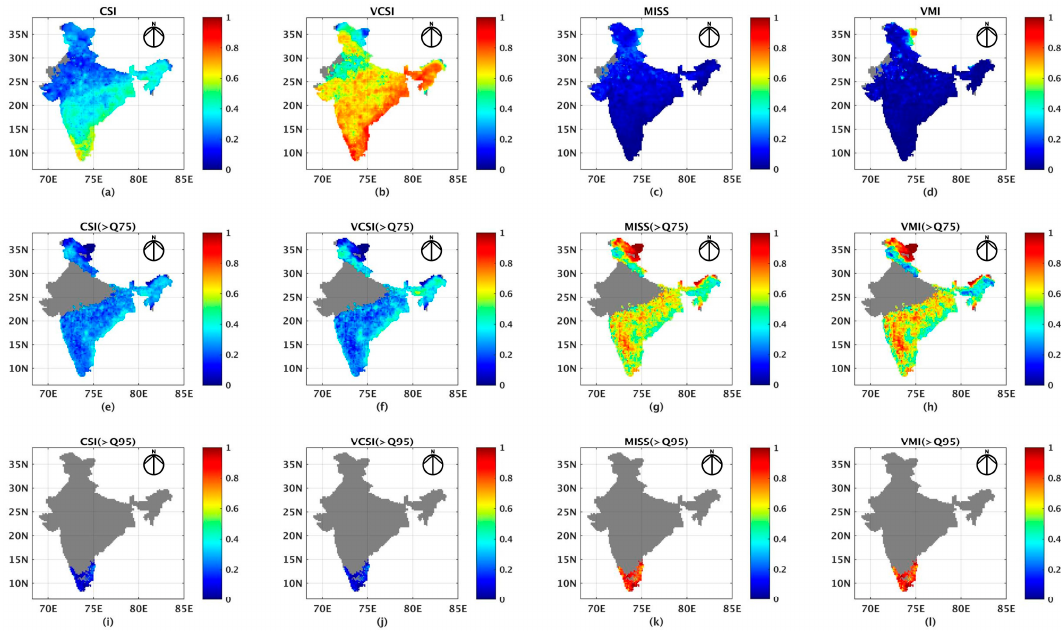
Figure 11. ( a – l ) Spatial distribution of categorical indices for the ON months over India for daily and higher quantiles of precipitation using MSWEP and IMD daily precipitation data from 1979 to 2013 showing CSI ( a , e , i ); VCSI ( b , f , j ); MISS ( c , g , k ); and VMI ( d , h , l ).